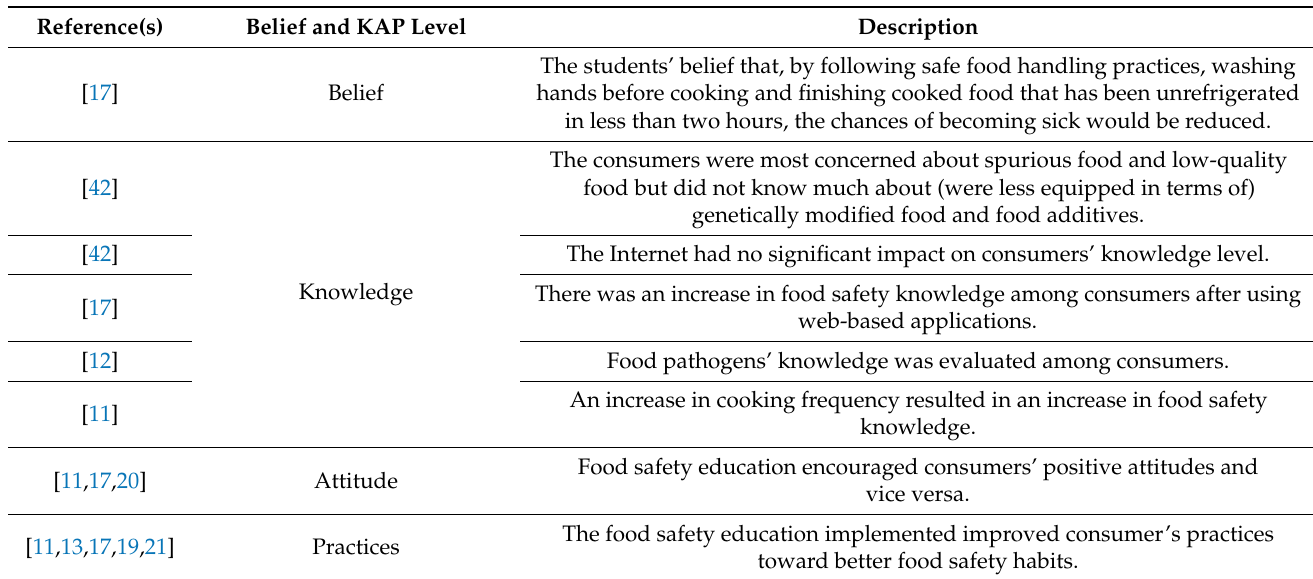
Table 5. Food safety KAP among